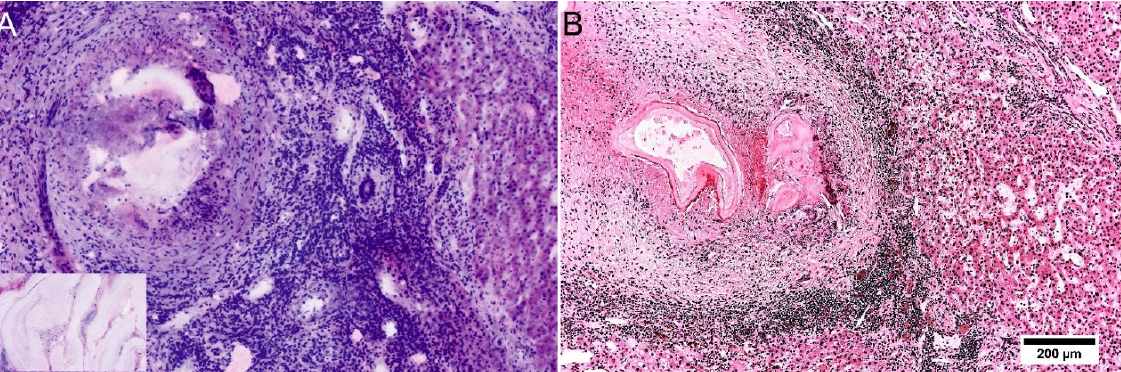
Figure 7. Manifestations of Echinococcus multilocularis in FCM scans and conventional histology. A/B: Echinococcus multilocularis in FCM ( A ) and conventional histology (( B ), HE staining). One of multiple daughter cysts are shown in the pictures with characteristic layers. The outer layer contains granulation tissue with marked inflammatory infiltrates and foreign body reaction. Characteristic laminated acellular material of the middle layer is represented also in FCM scans (inlay).